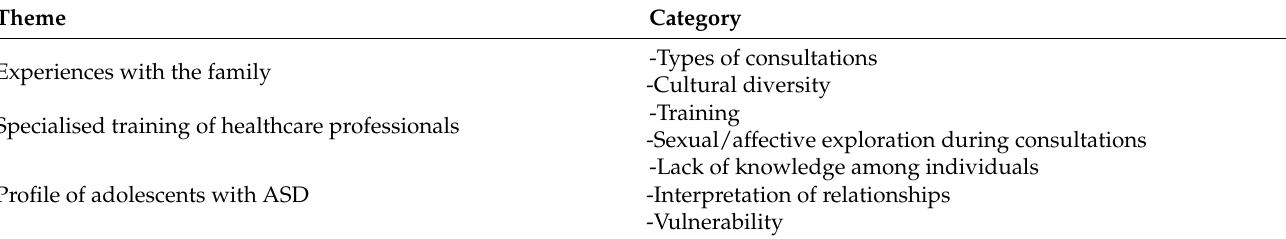
Table 4. Themes and categories identified from healthcare